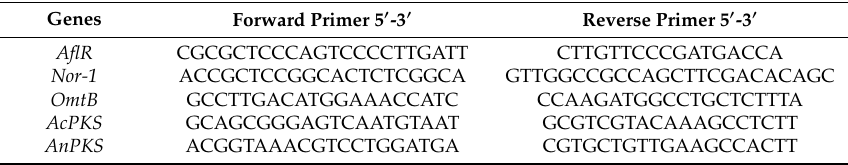
Table 1. Sequence of primers used for PCR analysis [22–24].